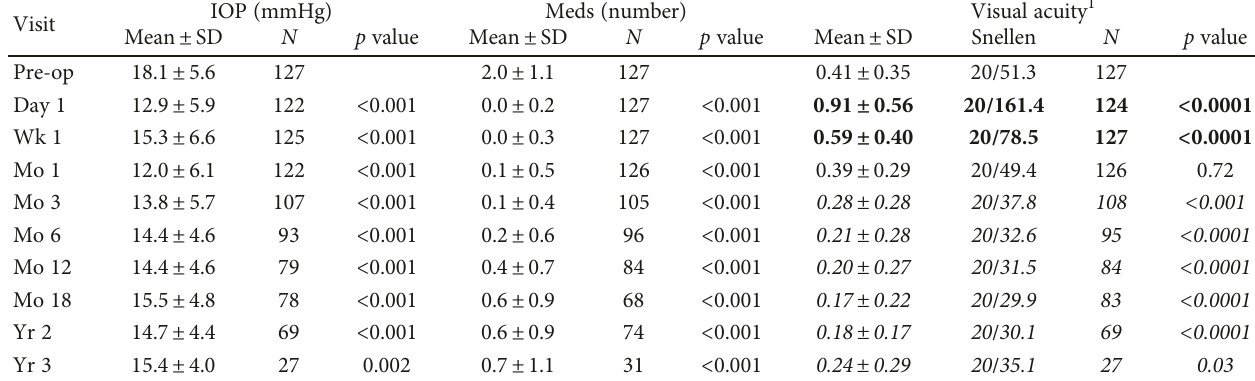
Table 4: Outcome measurements by visit (eyes with